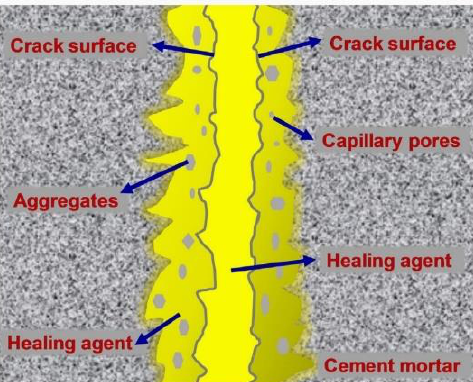
Figure 6. The interface between the healing product and the original fracture surface. Reprint with the permission from ref.[41]. Copyright 2022 Elsevier.